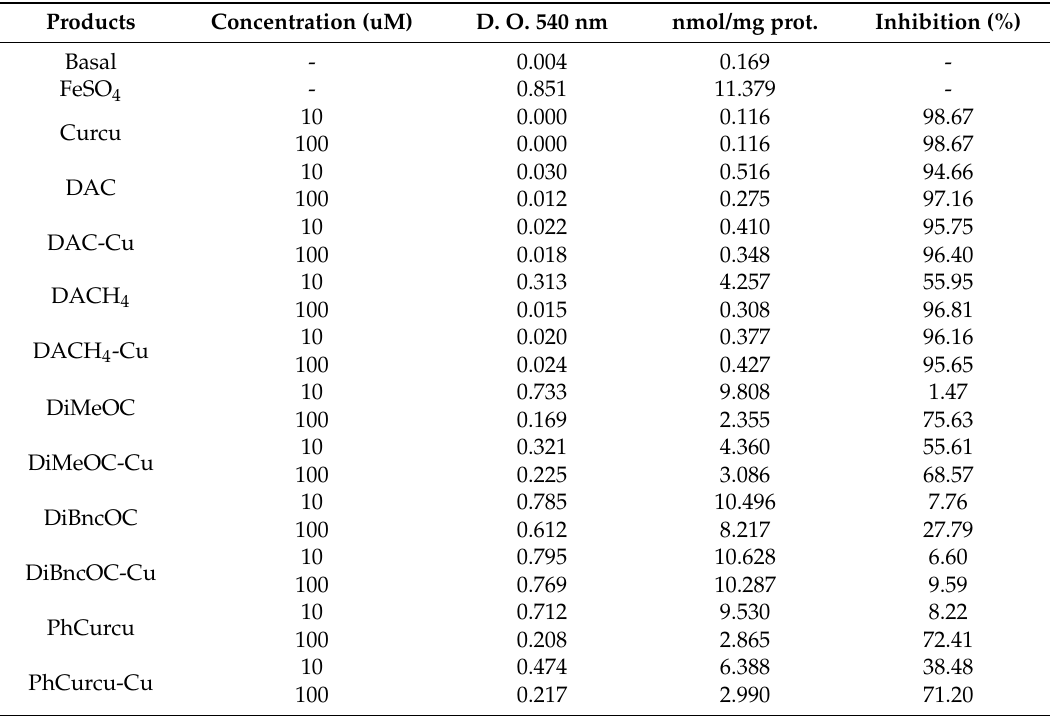
Table 4. Lipoperoxidation Screening of ligands and their copper complexes 1 – 10 .